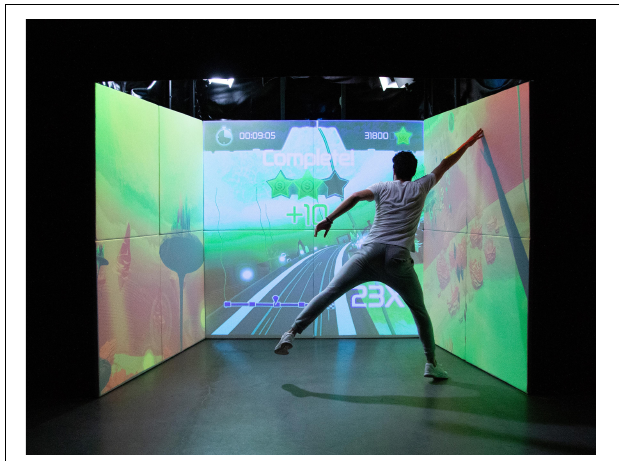
FIGURE 1 | Functional high-intensity interval training in the